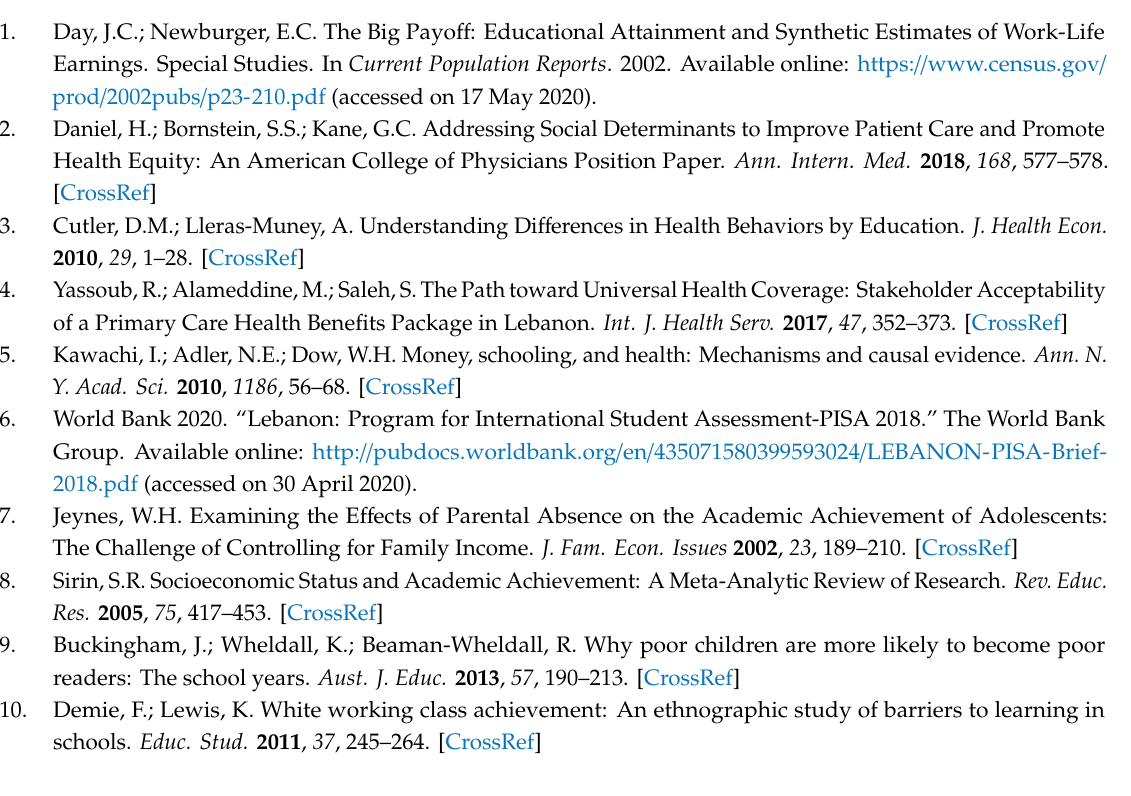
Dietary behavior, Table S3: Breakfast Questions, Table S4: Physical Activity, Table S5: Socio-cognitive